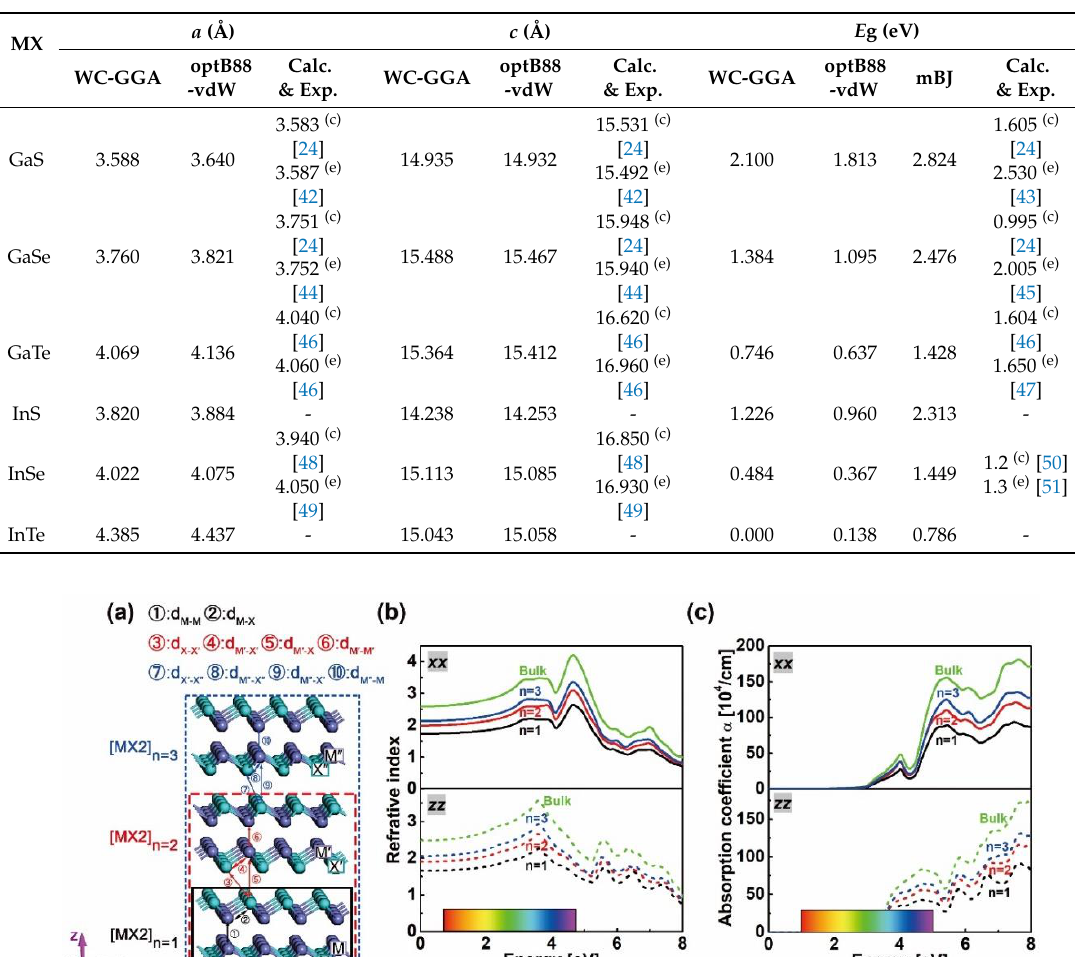
Table 1. Calculated lattice constants a and c and bandgaps of bulk MX (M = Ga, In; X = S, Se, Te) by using WC-GGA, optB88-vdW and mBJ functionals, as well as other theoretical “(c)” and experimental “(e)” data.